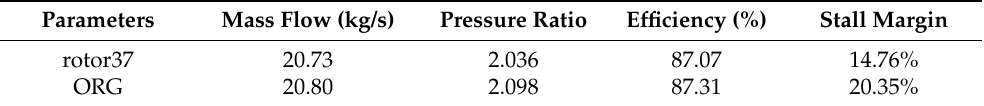
Figure 4. The characteristic comparison of rotor37 and the original tandem rotor. ( a ) the isentropic efficiency. ( b ) the total pressure ratio. Table 2. Comparison of the design point performance and stall margin of rotor37 and the tandem rotor.